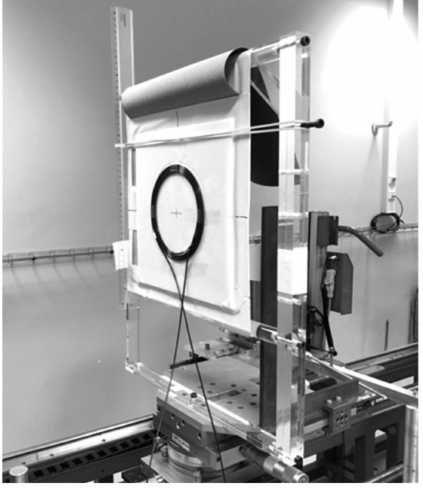
Figure 4. IVISCAN ® probe placement on the calibration bench at LNHB. Detector–source distance is 120 cm. The field was considered homogeneous within the polystyrene